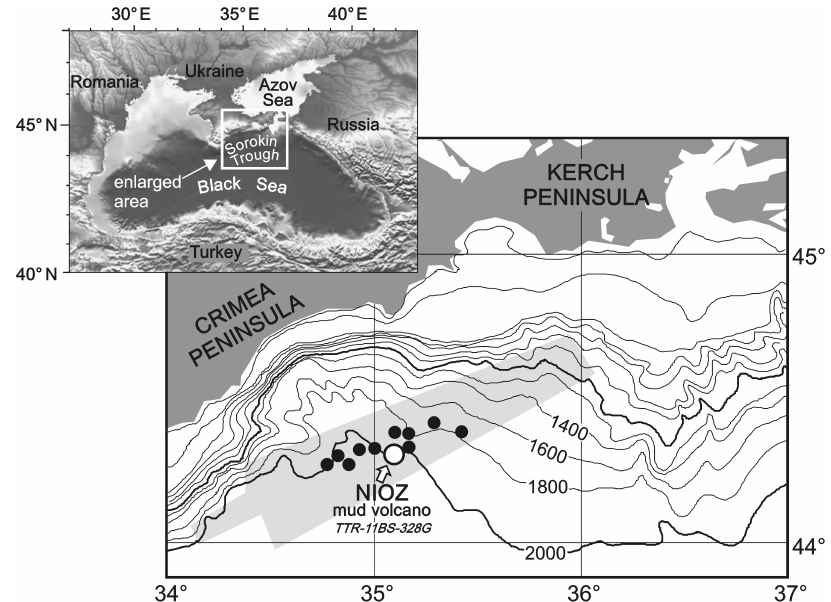
Figure 1. Location map of the study area (light gray) within the Sorokin Trough, NE Black Sea. Filled circles indicate the mud volcanoes investi- gated during the 11th Training- through-Research cruise (July–Septem- ber 2001); the open circle indicates the position of the NIOZ mud